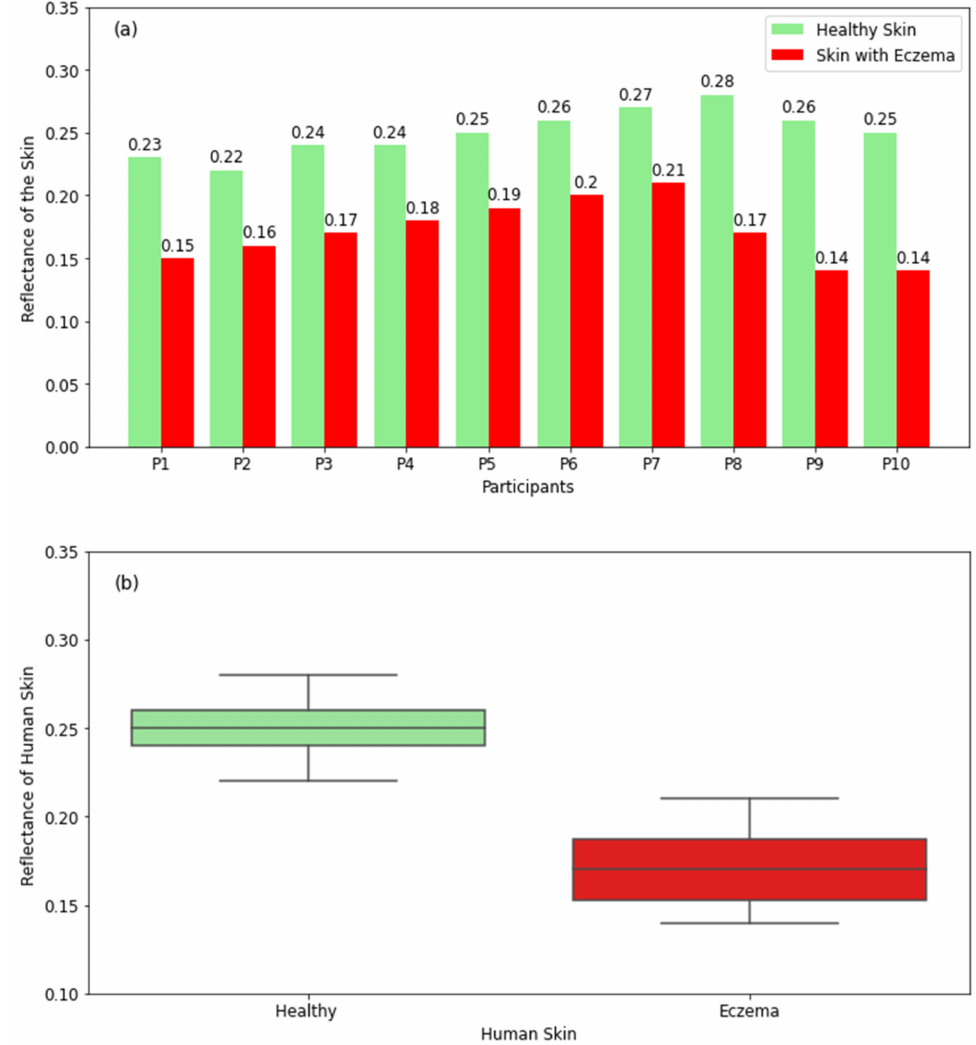
Figure 10. Reflectance measurements in a sample of 10 participants having eczema compared with the closest region of healthy skin on the same participant ( a ). The boxplot shows the range of the reflectance of healthy skin and eczema ( b